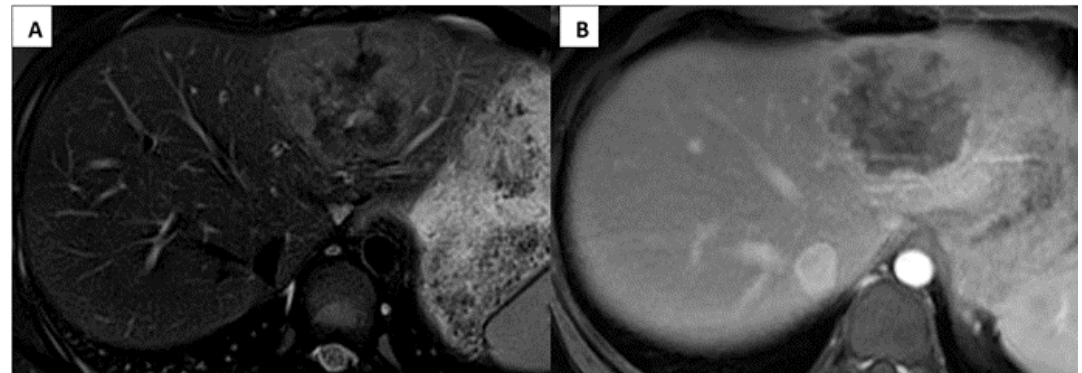
Figure 1. Imaging appearance of fibrolamellar hepatocellular carcinoma. Axial MRI liver demonstrates the PRETEXT II single left hepatic mass in segments II, III, and IVa with mild peripheral hyperintensity and central hypointensity on T2 fat saturation images ( A ) and iso to hypointensity on the post contrast phase ( B ).